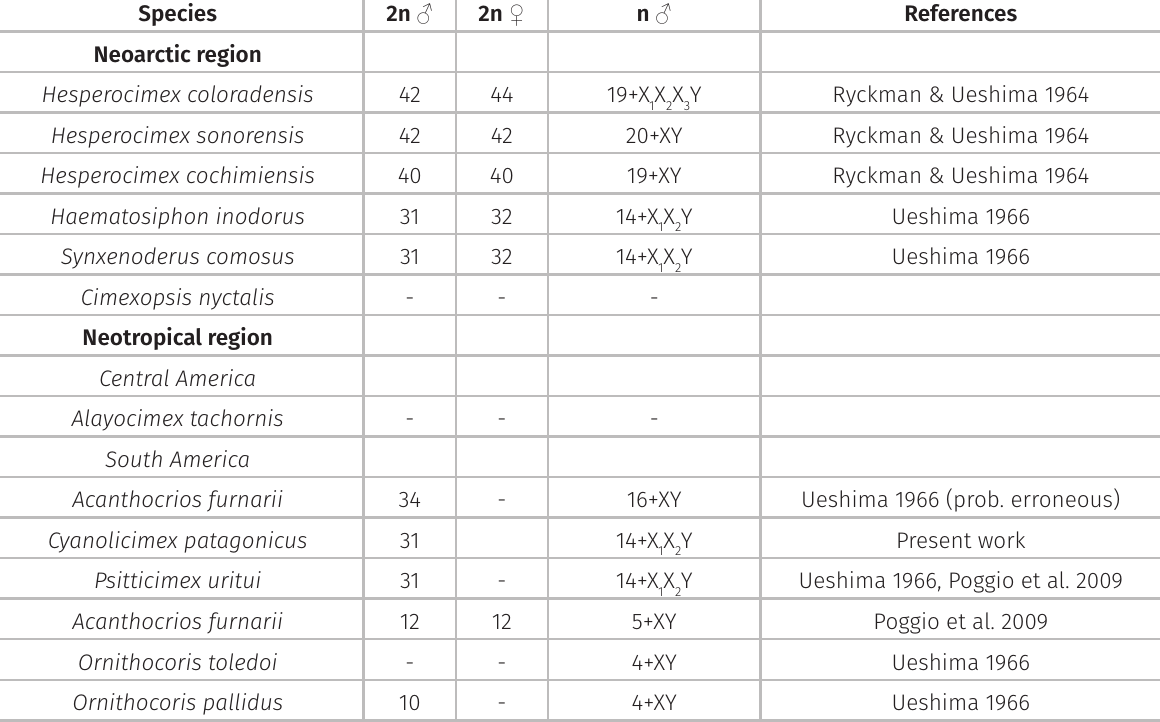
Table I. Chromosome numbers and their sex chromosome systems in Haematosiphoninae (Hemiptera: Cimicidae). The Cimicidae species were ordered in decreasing number of chromosomes on each biogeographic region (except those with unknown